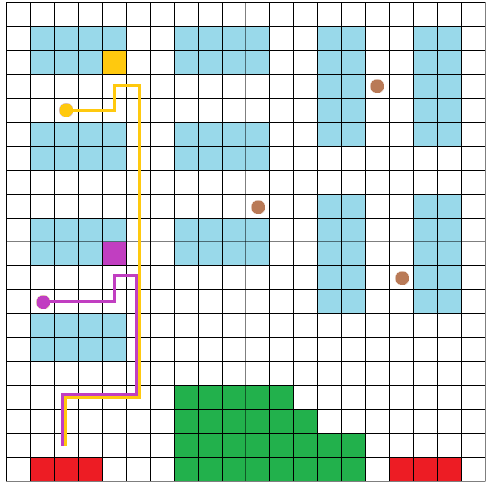
Figure 3. This is an illustration of the proposed methodology. After a task is allocated to the robots, each robot follows the path to reach its destination. Timing is crucial; however, it cannot be represented with an image. The two robots allocated with the task are located at the same tile at different times; therefore, the paths are